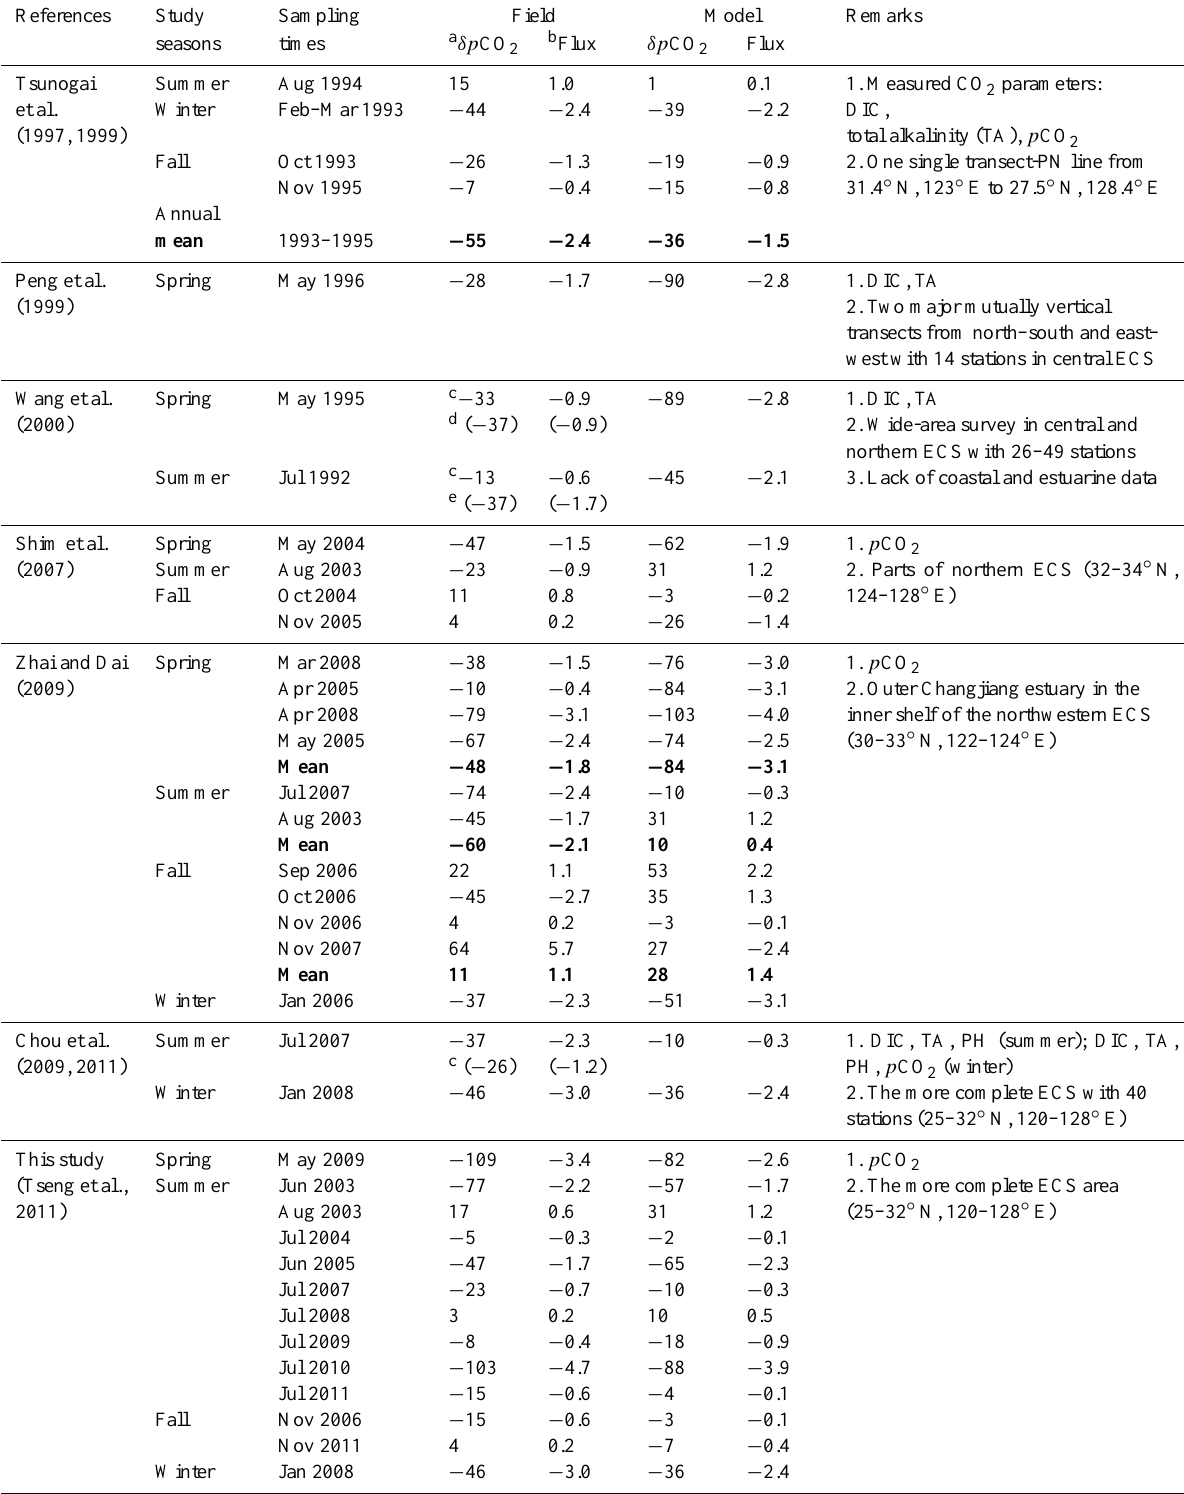
Table 3. Summary of the CO 2 results in the ECS reported in the previous studies and obtained from this